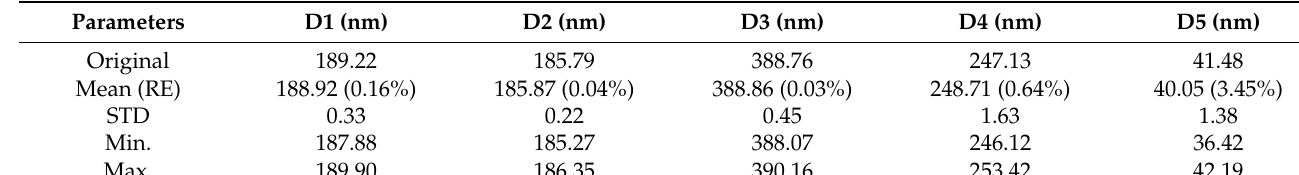
Table 1. The statistical results of inverse design for the AR coating case.